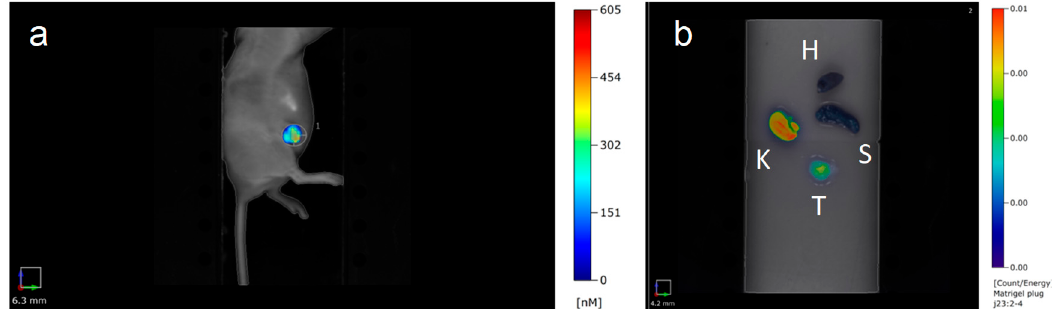
Figure 10. ( a ) Fluorescence imaging of a tumor ‐ bearing mouse laid on its left flank after intravenous injection of Au@DTDTPA ‐ Cy5 nanoparticles. ( b ) Fluorescence imaging of ex vivo organs (heart (H), kidney (K), spleen (S), and tumor (T)) after intravenous injection of Au@DTDTPA ‐ Cy5 nanoparticles.